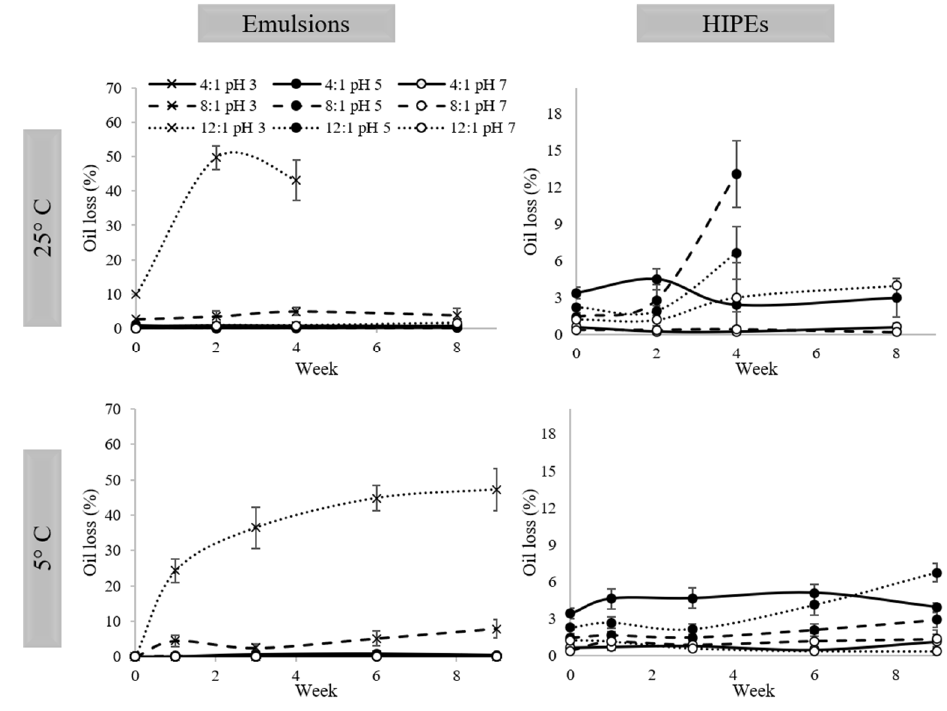
Figure 7. Oil loss of emulsions and HIPEs stored at 5 and 25 °C.